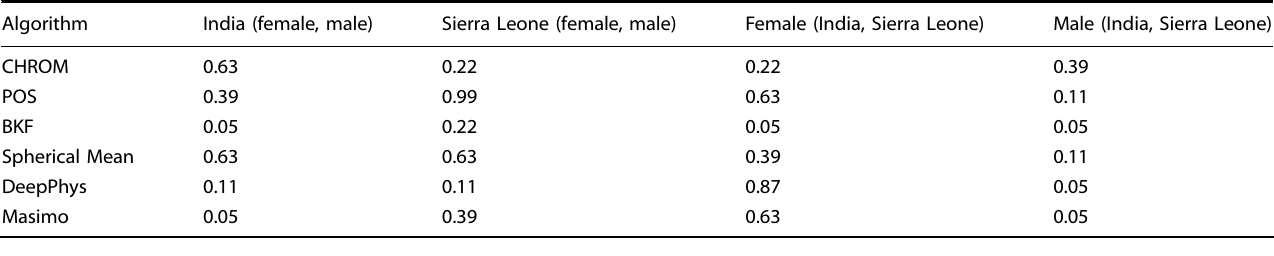
Table 8. Gender analysis within populations for rPPG methods showing p values for hypothesis tests de fi ned in the section “ Tests within populations for rPPG methods with respect to gender ” .